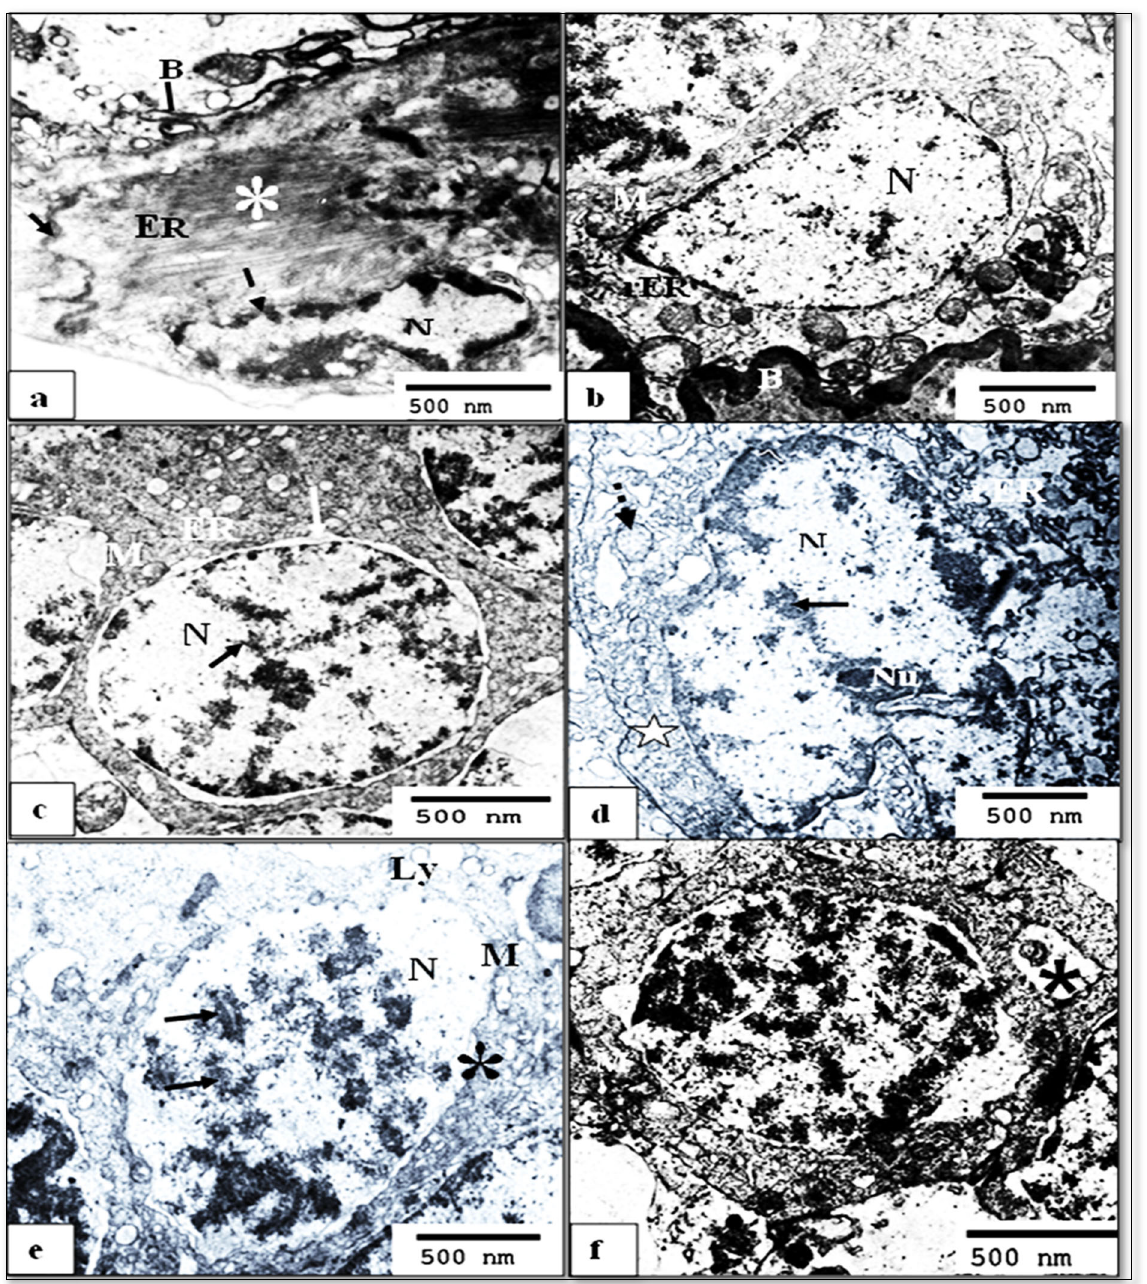
Figure 4. Transmission electron micrograph of Callinectes sp. testis showing ( a ). basal part of seminiferous tubule with myoid cell, nucleus (N), nuclear pores (dashed arrows), the cellular junction (arrows), contracted fibers (star), endoplasmic reticulum (ER), and basement membrane (BM). Spermatogonia rest on the basement membrane (BM) with nucleus (N) contains dispersed euchromatin, many dense mitochondria (M), and rough endoplasmic reticulum (rER) ( b ). Preleptotene stage with nucleus (N), small chromosome (arrow), double nuclear envelope (dashed arrow), few mitochondria (M), and small vesicular endoplasmic reticulum (ER) ( c ). Leptotene stage with nucleus (N), clear thread- chromosomes (arrow), centriole (dashed-arrow), vesicular rough endoplasmic reticulum (rER), and annulated lamellae (dashed arrow) ( d ). Zygotene stage with nucleus (N) has intertwined thick chromosomes, paired cords (black arrows), poor mitochondria (M), vesicular rough endoplasmic reticulum (star), nuage (white arrow), secondary lysosome (Ly2) ( e ). The Pachytene stage has a nucleus (N), chromosomes have synaptonemal complexes (arrows), poor small mitochondrion (M), free ribosomes (R), and myelin body (star) ( f ).